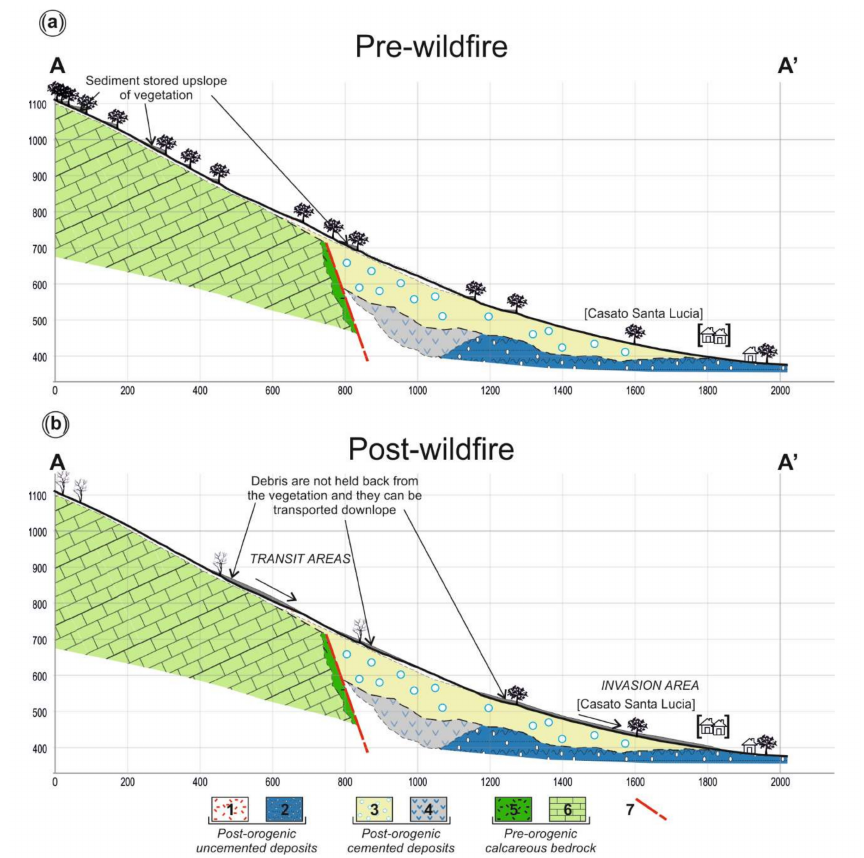
Figure 16. Geological cross-section of the pre—( a ) and post-wildfire ( b ) debris flow channel (cross-section trace in Figure 12 and in Figure 14). Legend: (1) Slope deposits; (2) alluvial plain deposits; (3) alluvial fan deposits; (4) paleo-landslide deposits; (5) cataclastic bedrock; (6) fractured bedrock; (7) normal